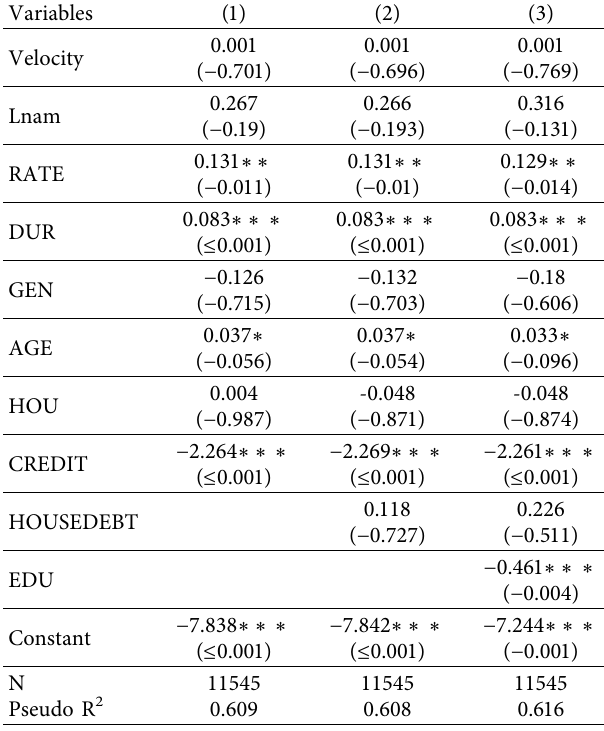
Table 7: Rational verification of investor herd